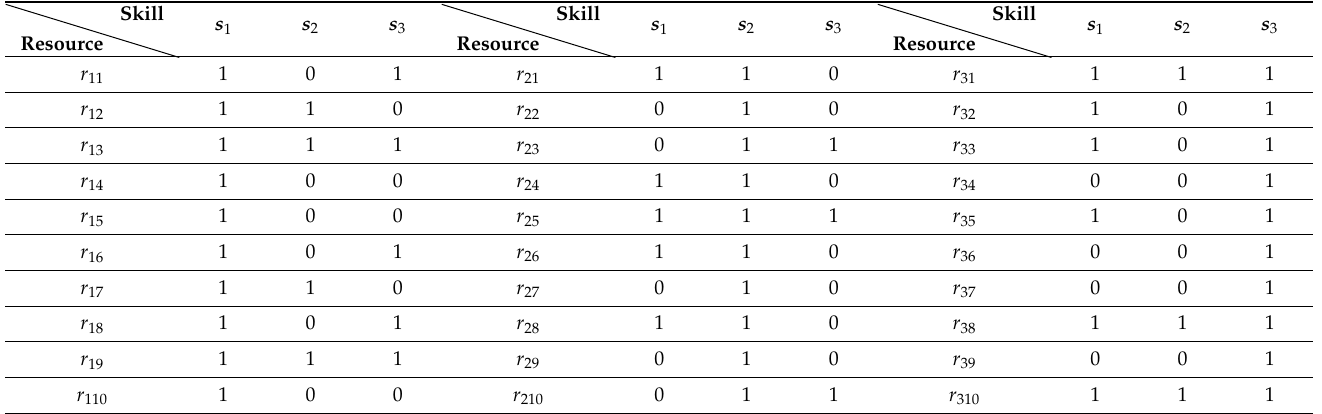
Table A1. The skill matrix mastered by resources.